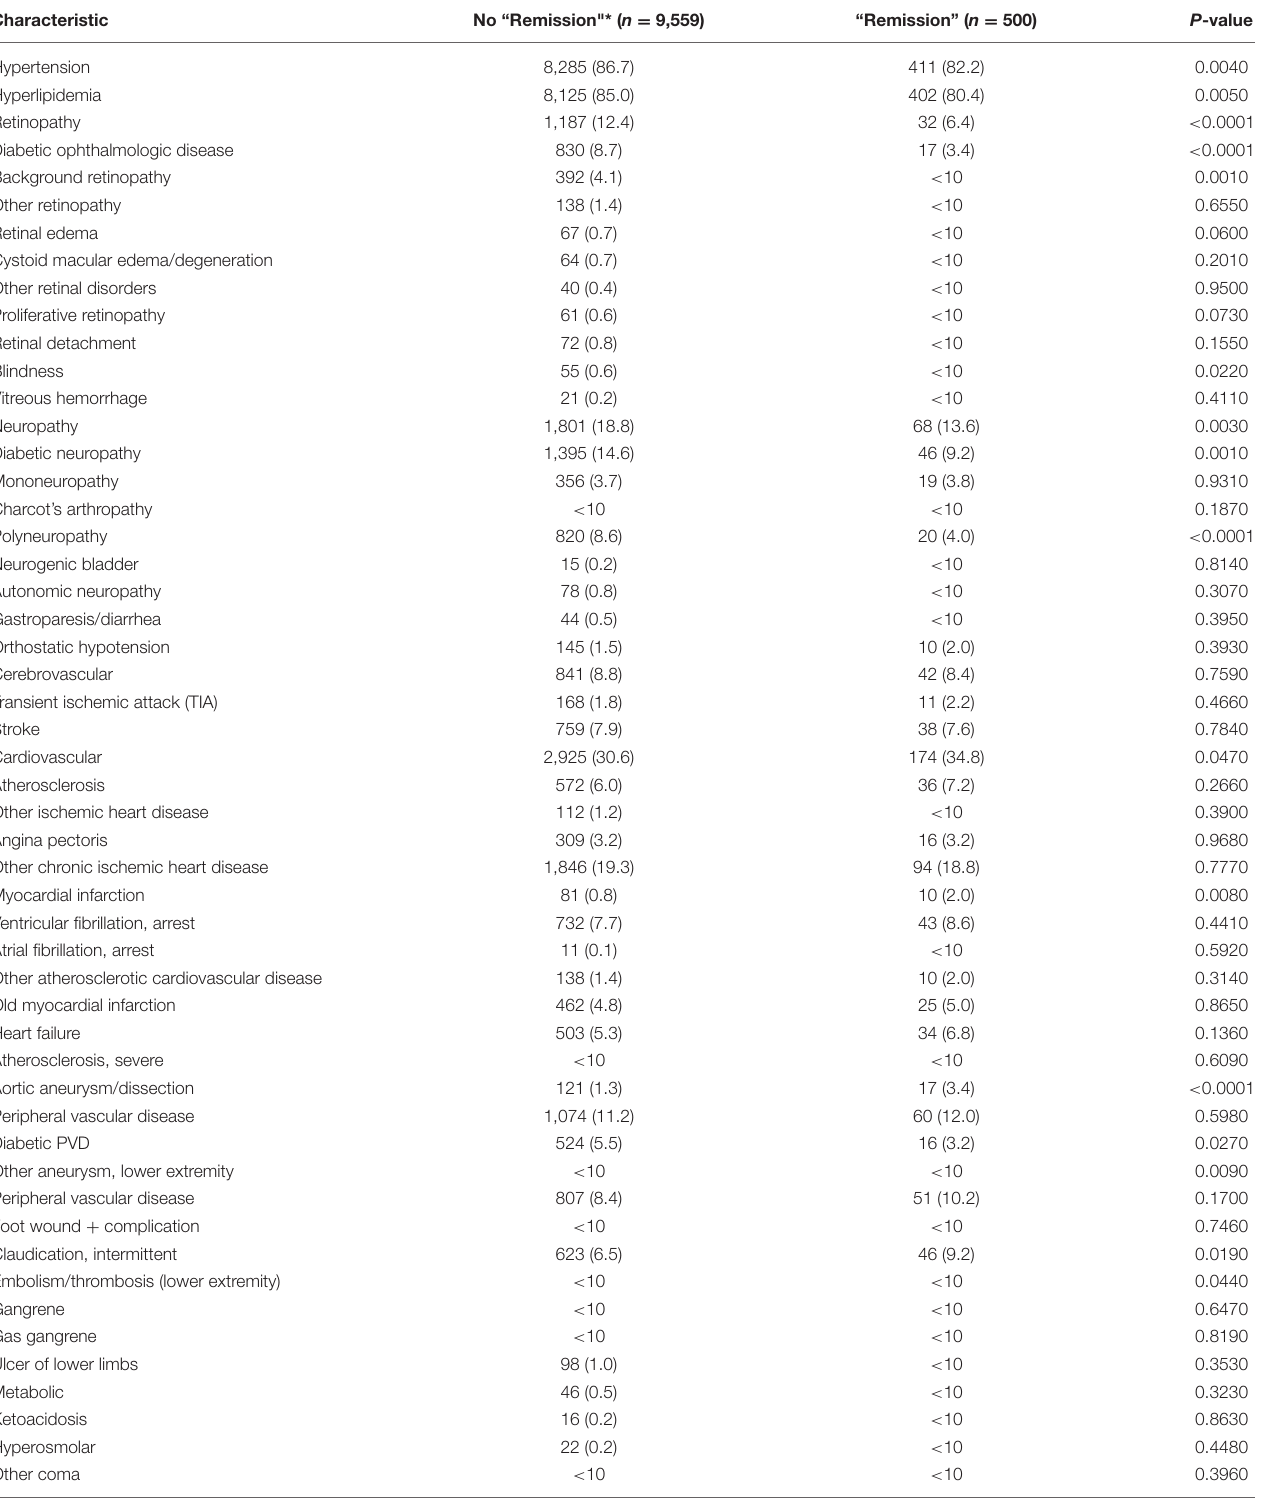
TABLE 2 | Baseline